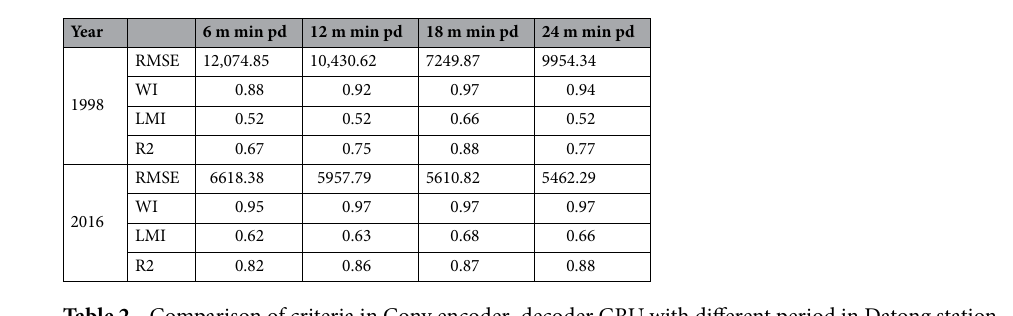
Table 2. Comparison of criteria in Conv encoder–decoder GRU with different period in Datong